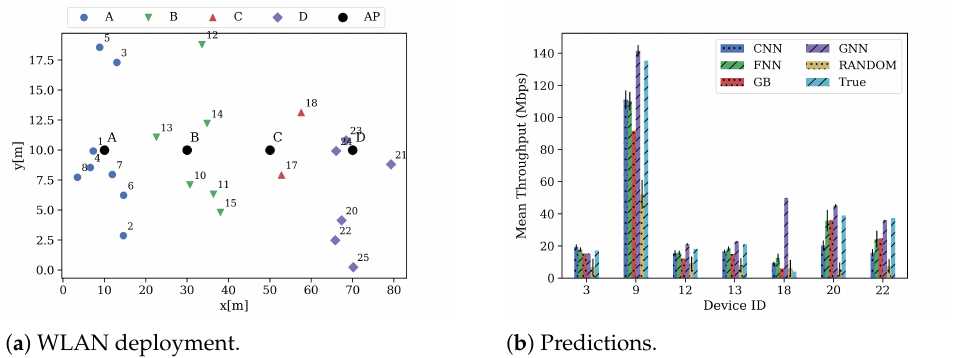
Figure 9. Deployment and predictions of some devices of test scenario 1.